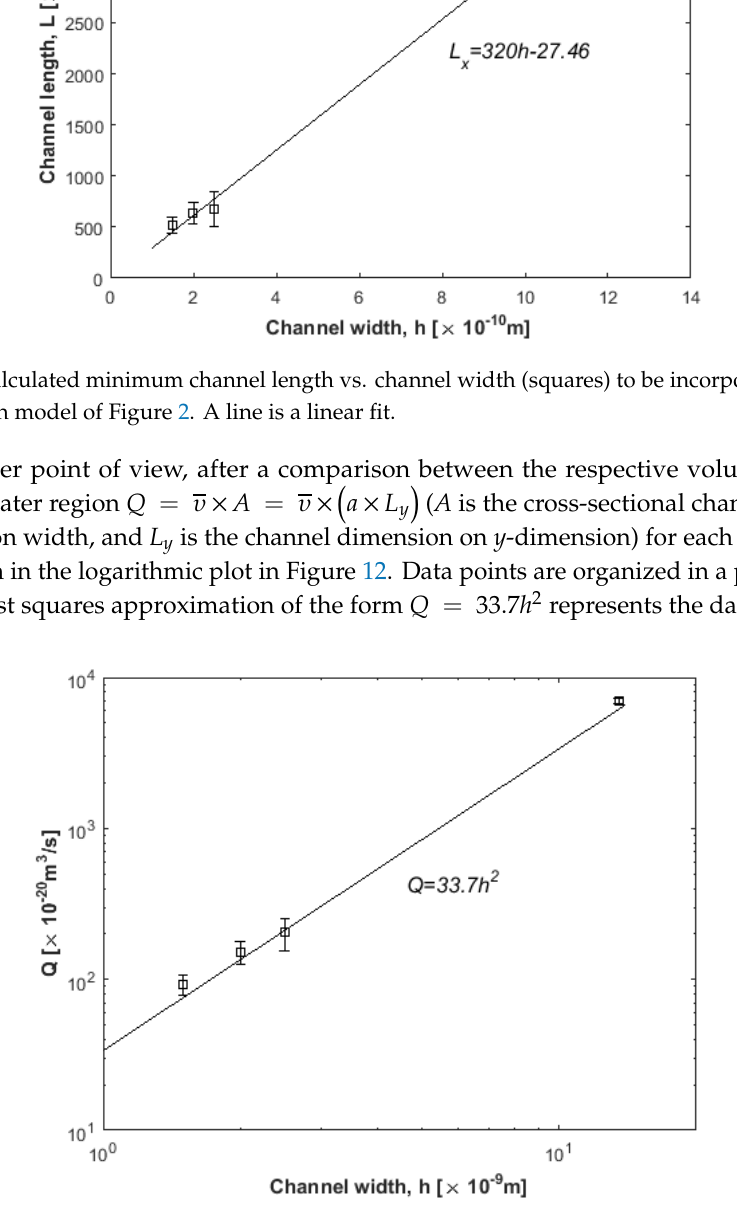
Figure 12. Volumetric flow rate, Q , vs. channel width (squares). Line is power-law least-squares fit.